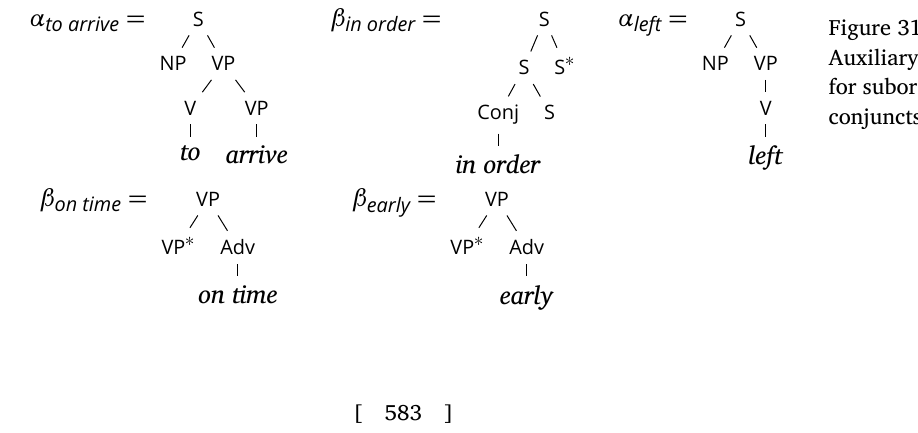
Figure 31: Auxiliary trees for subordinate